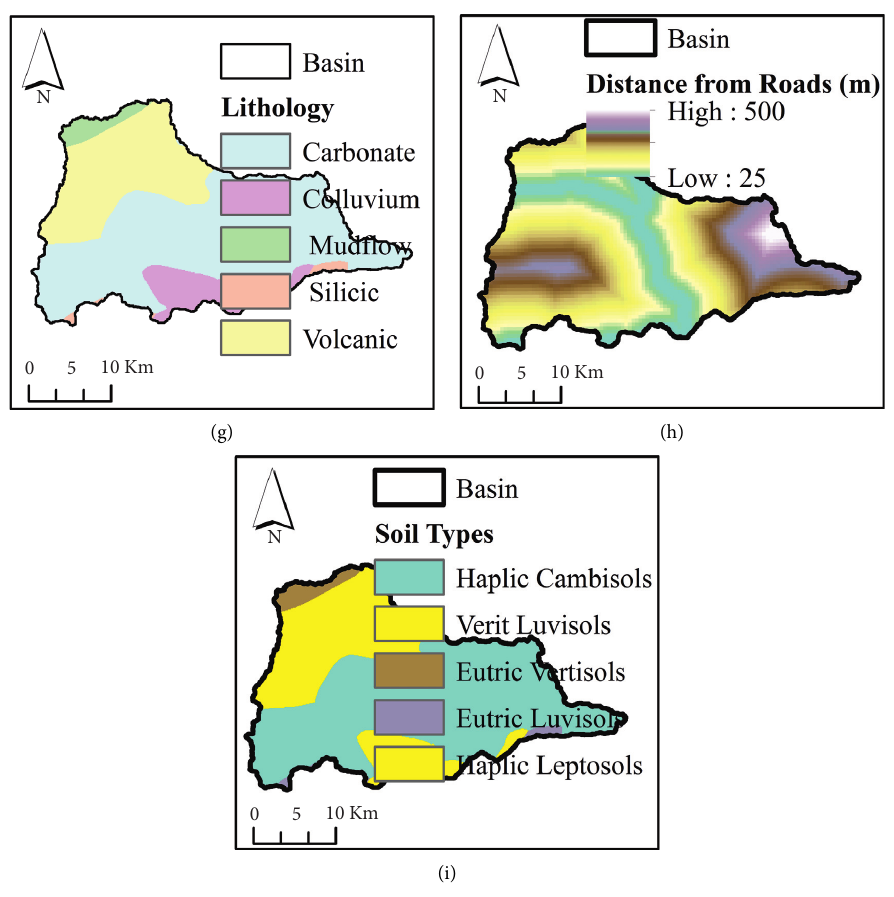
Figure 2: Flood causing factors: (a) rainfall, (b) LULC, (c) TWI, (d) SPI, (e) elevation, (f) geomorphology, (g) lithology, (h) distance from roads, and (i) soil